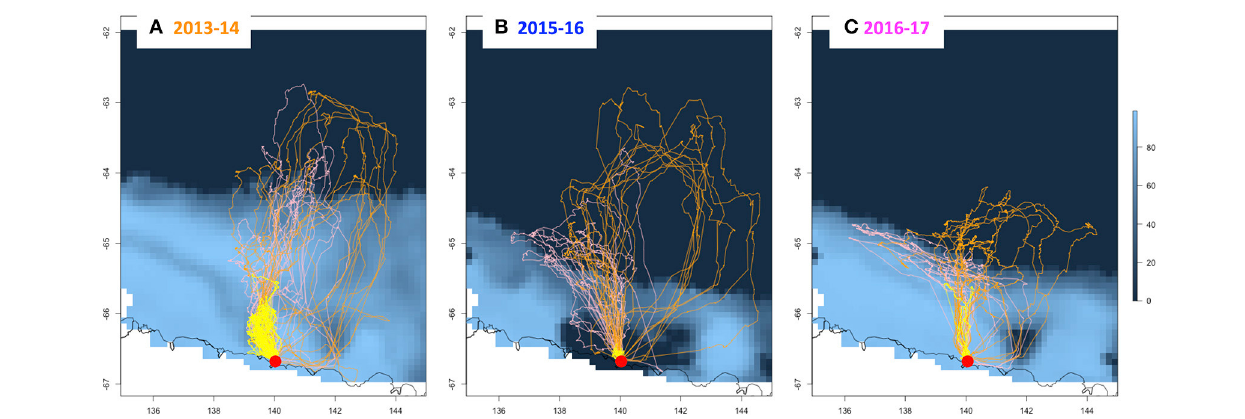
FIGURE 3 | Foraging tracks of Adélie penguin females (orange) and males (pink) during their first incubation trips, and males and females during chick rearing (yellow) superimposed on maps of sea-ice concentration (Dec. 1st of each year) from open water (navy blue) to maximum ice concentration (lighter shades of blue), for (A) 2013–14, (B) 2015–16, and (C) 2016–17. The periphery of the continent is indicated by a black border. The colony is indicated by a red dot.